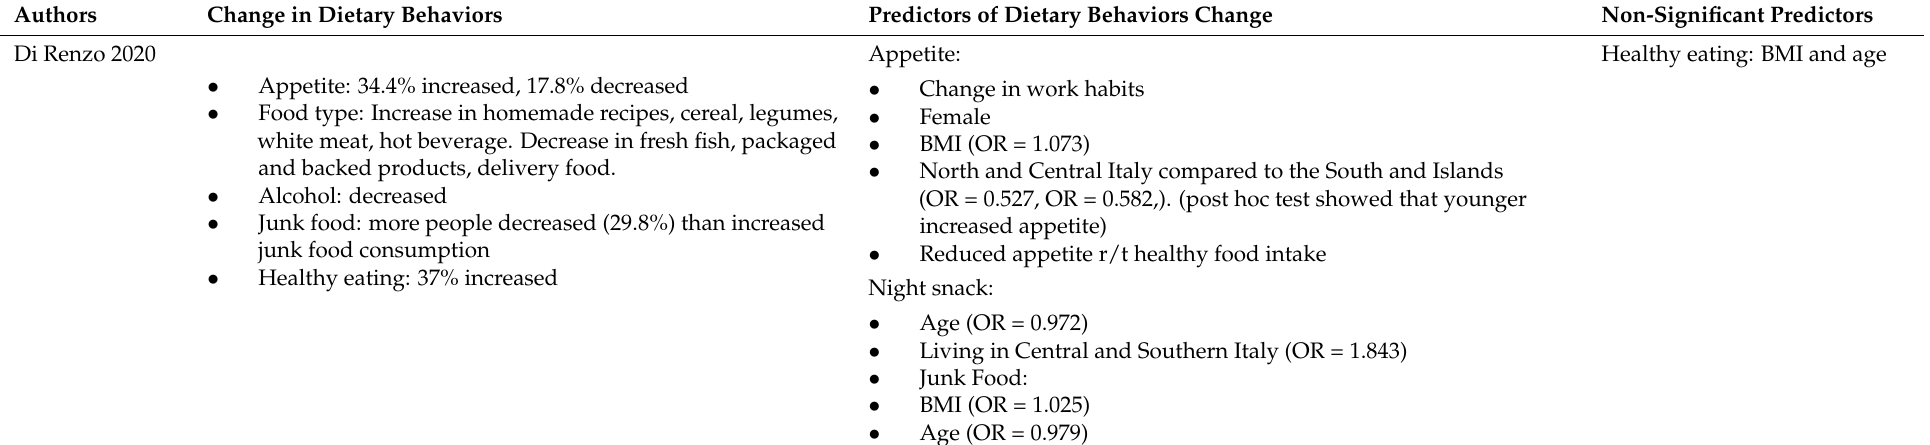
Table 4. Changes in dietary behaviors and the corresponding predictors during the COVID-19